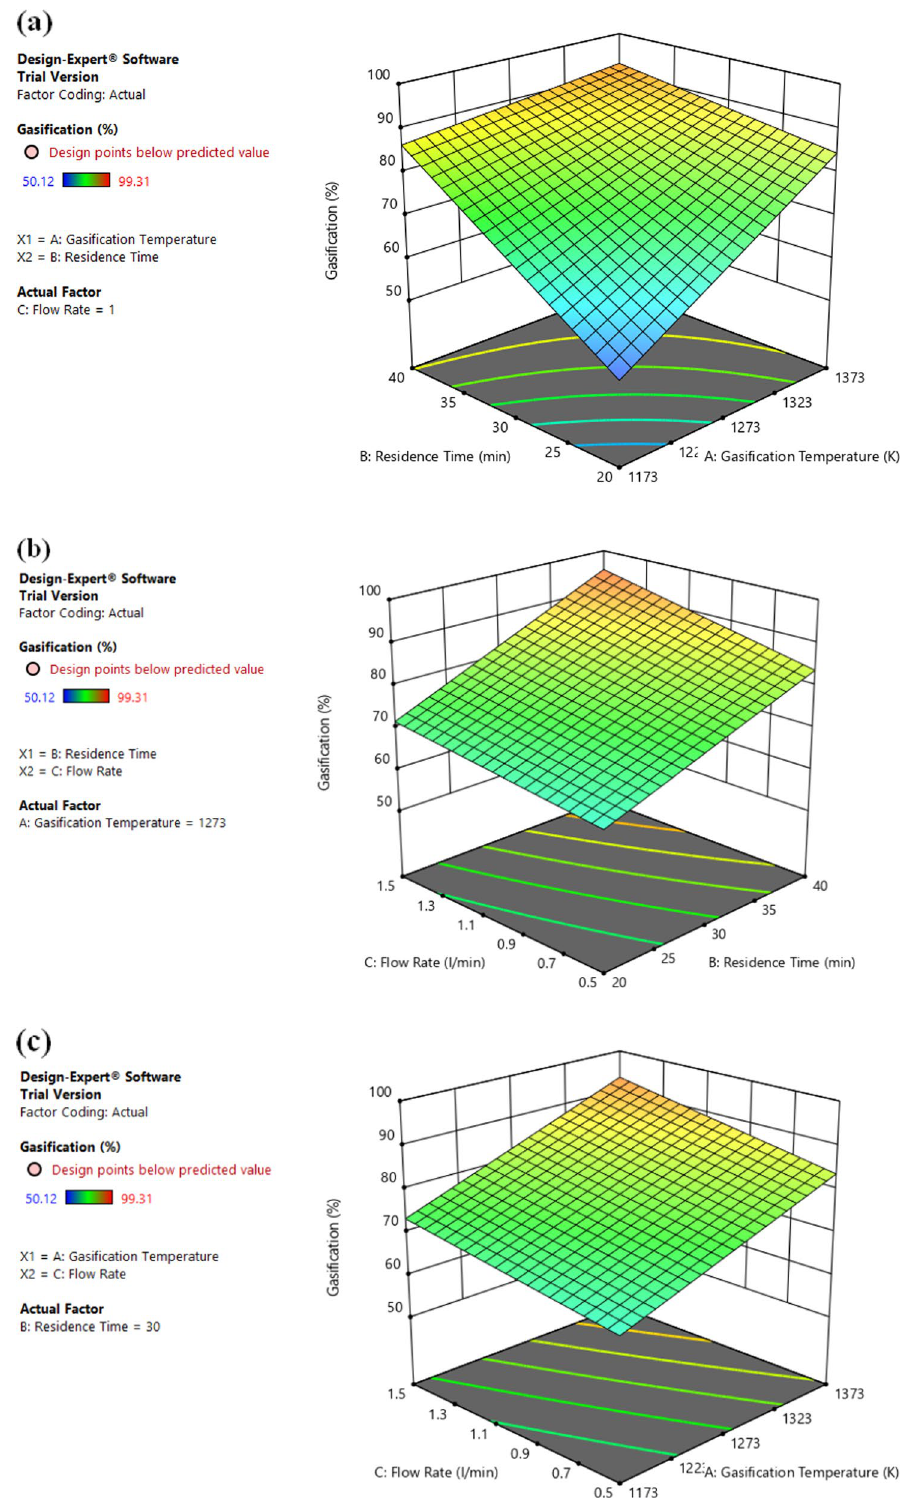
Fig. 10 3-D surface plot of LVWC-II gasification versus a Residence time and gasification temperature b Flow rate and residence time and c Flow rate and gasification